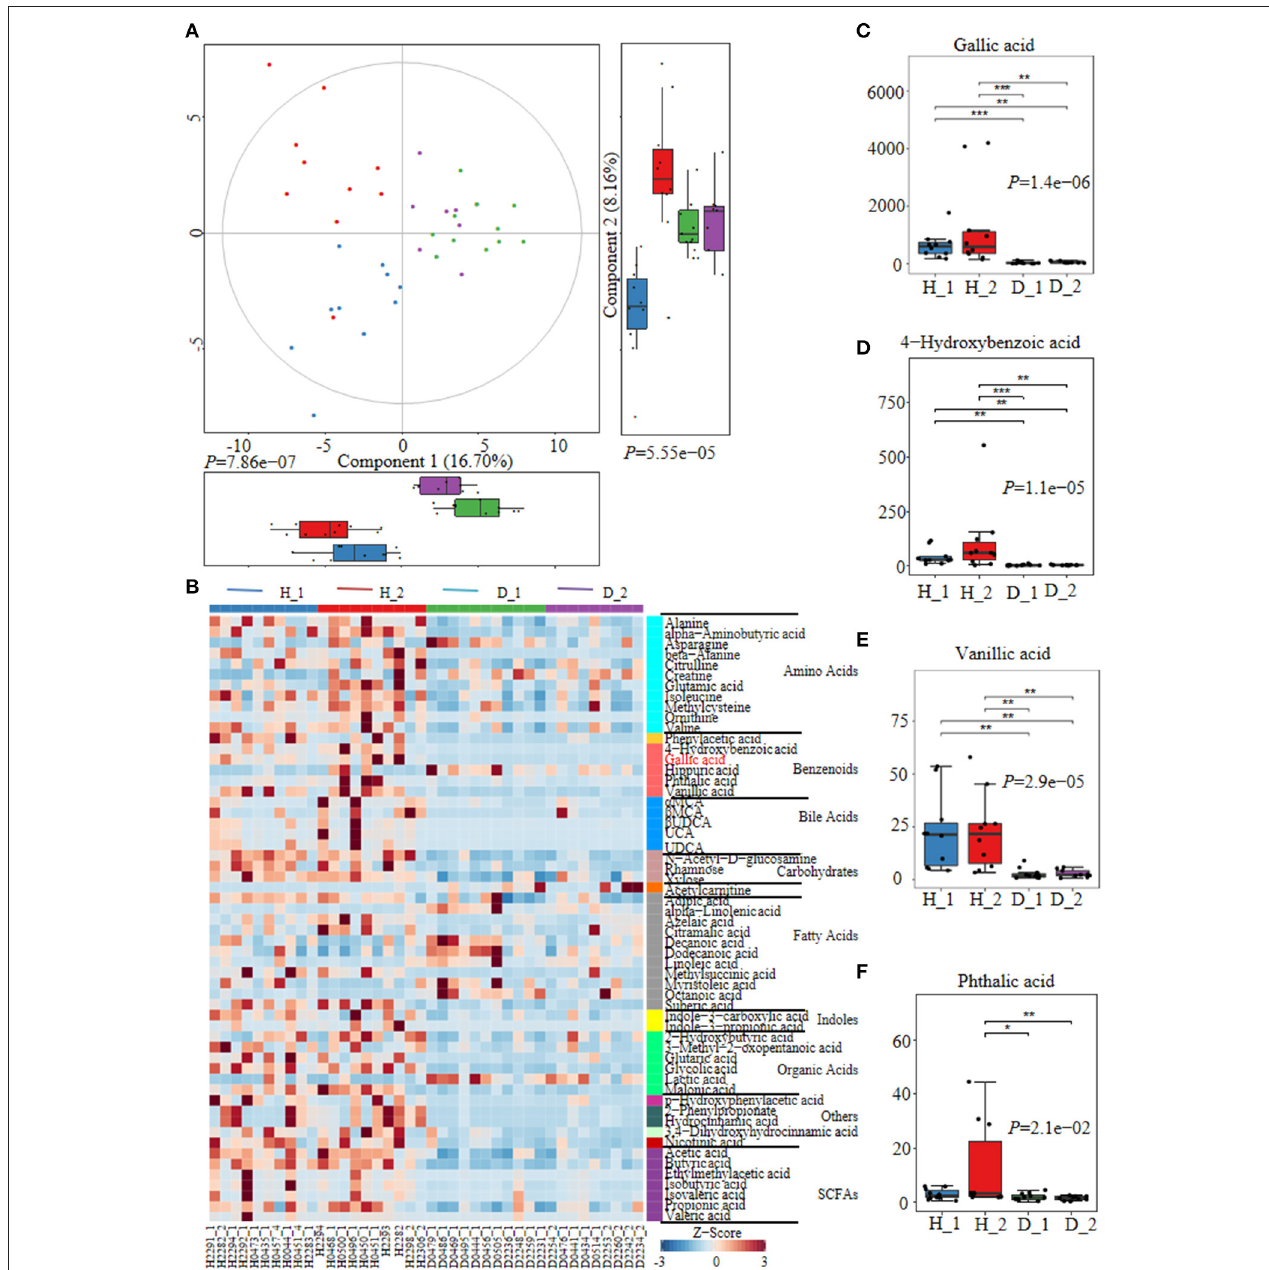
FIGURE 2 | The alterations of fecal metabolome profiles of neonatal calves post ESBL-EAEC infection. (A) Partial Least Squares Discriminant Analysis (PLS-DA) was used here to cluster the fecal metabolome profiles of calves. Metabolome profile for the H_1, H_2, D_1, or D_2 groups was shown in the same color, respectively. Data were mean ± SEM. P -values were acquired using the nonparametric Kruskal-Wallis test. (B) Unweighted paired group method with arithmetic mean (UPGMA) dendrogram was used to cluster the relative abundance of metabolites and results were shown using heatmap analysis. The color indicated the relative abundance of the metabolite in the group of samples, and the corresponding relationship between the color gradient and the value were shown in the gradient color block. The metabolite variation was demonstrated using Z-Score. Gallic acid (GA) was labeled red. The concentrations of fecal GA (C) , 4–hydroxybenzoic acid (D) , vanillic acid (E) , and phthalic acid (F) were displayed as box and dot plots. Data were mean ± SEM. p -values were determined using the nonparametric Kruskal-Wallis test. * p ≤ 0.05, ** p ≤ 0.01, *** p ≤